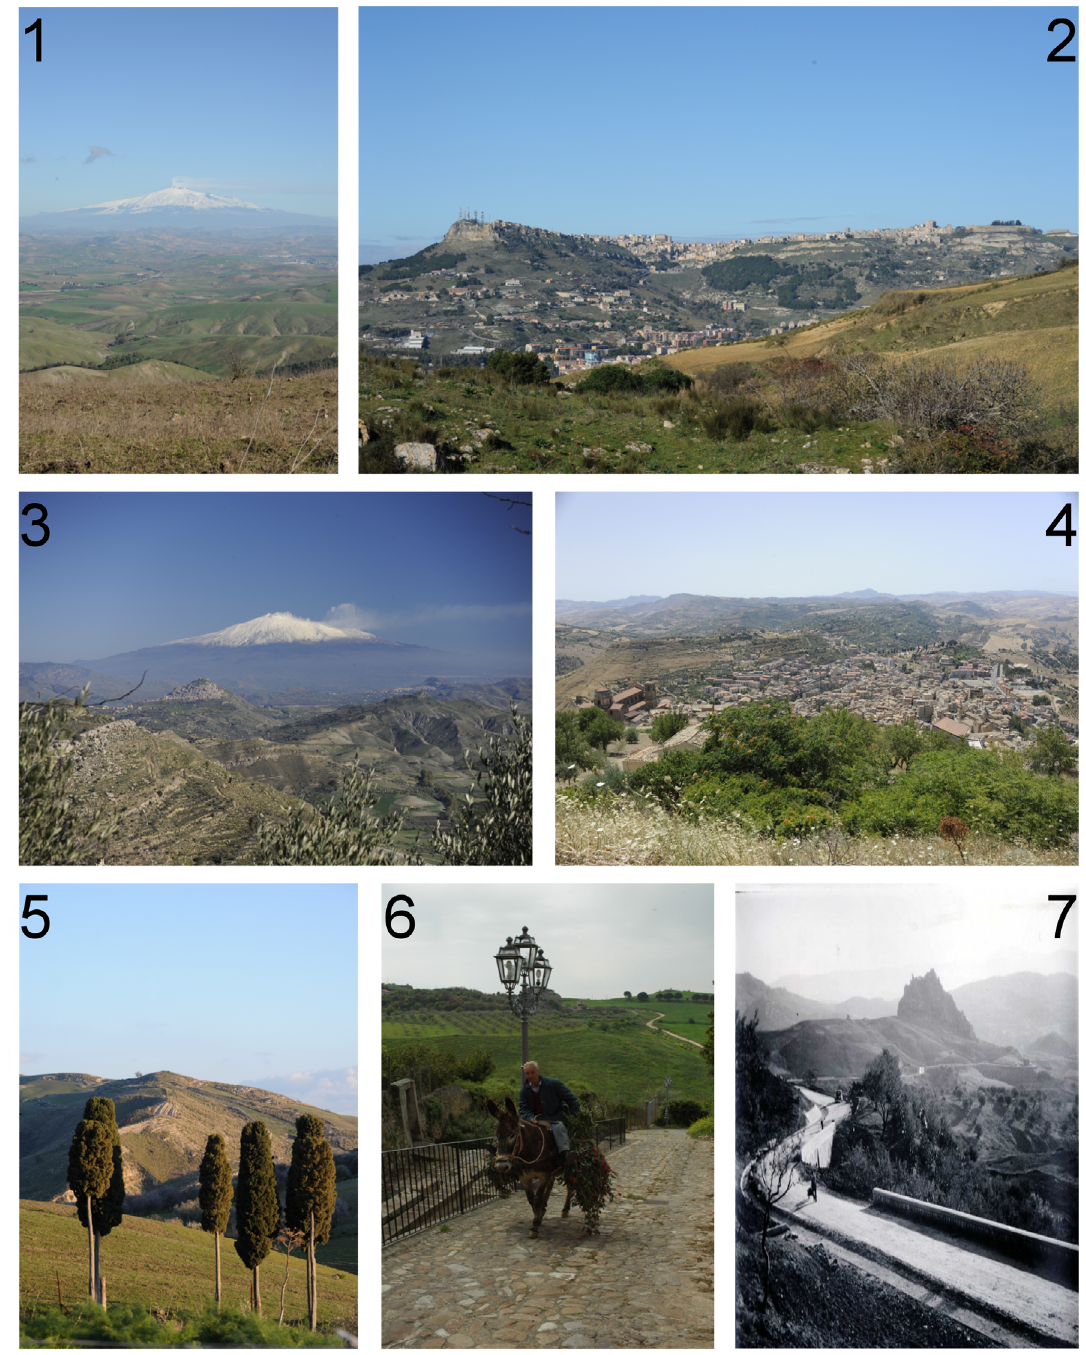
Fig. 2. Pictures of the main places mentioned within the text: 1 Dittaino’s valley from Cozzo Matrice, 2 Enna from Cozzo Matrice, 3 Agira from Assoro, 4 Agira from Ennas’ castle, 5 the road Enna–Agira at Piano Murra, 6 the medieval road entering in Lenoforte, 7 medieval road at the foothill of the castle of